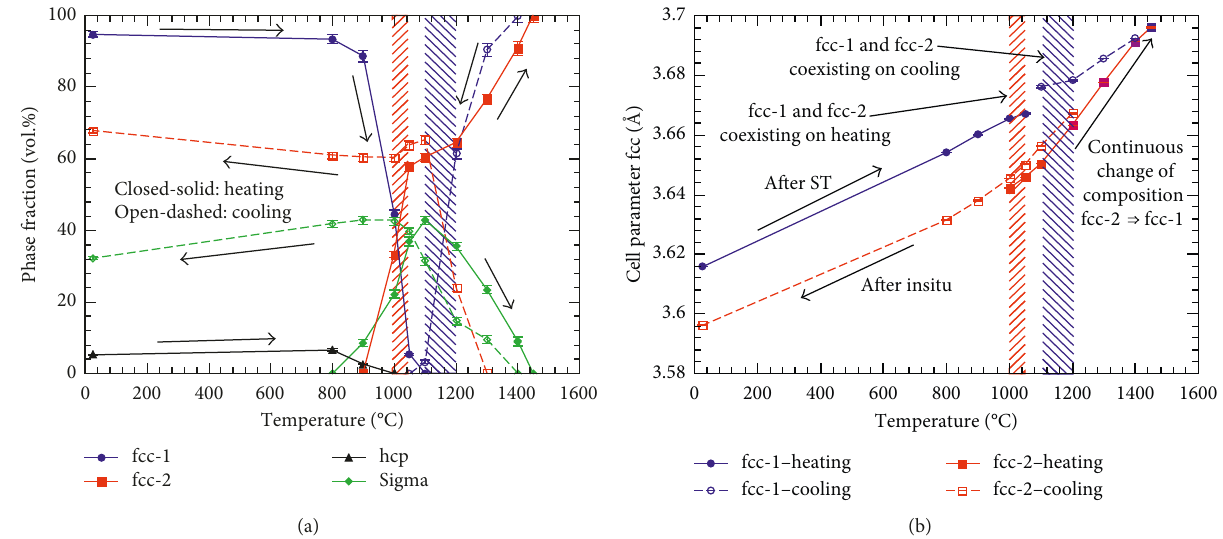
Figure 3: (a) Evolution of phase fraction for all phases as a function of temperature. (b) Evolution of the cell parameters for both fcc phases as a function of temperature during heating and